Question: Write a descriptive caption for this figure.
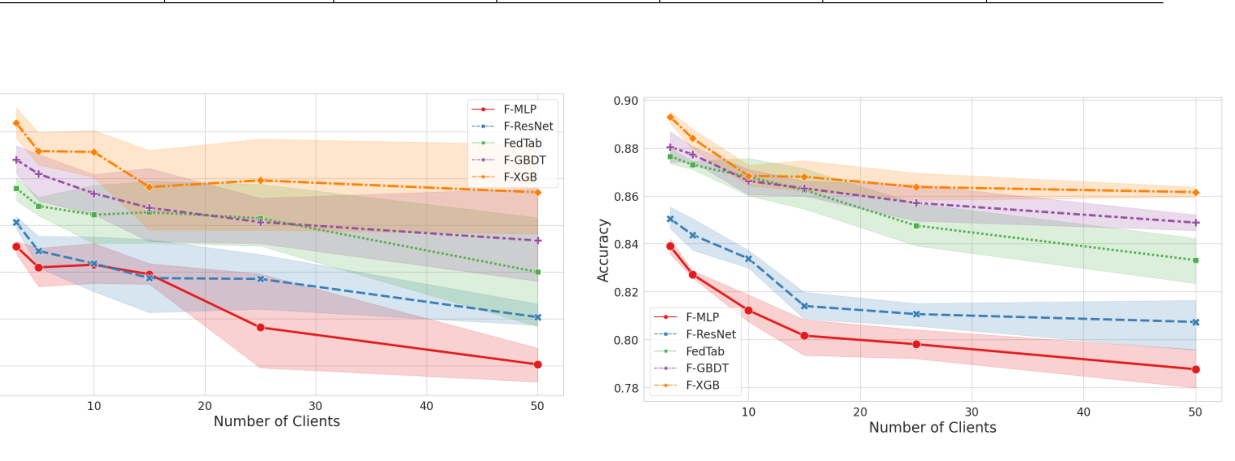
Answer: Models’ test accuracy for 3, 5, 10, 15, 25 and 50 clients on Synthetic dataset in homogeneous setting.